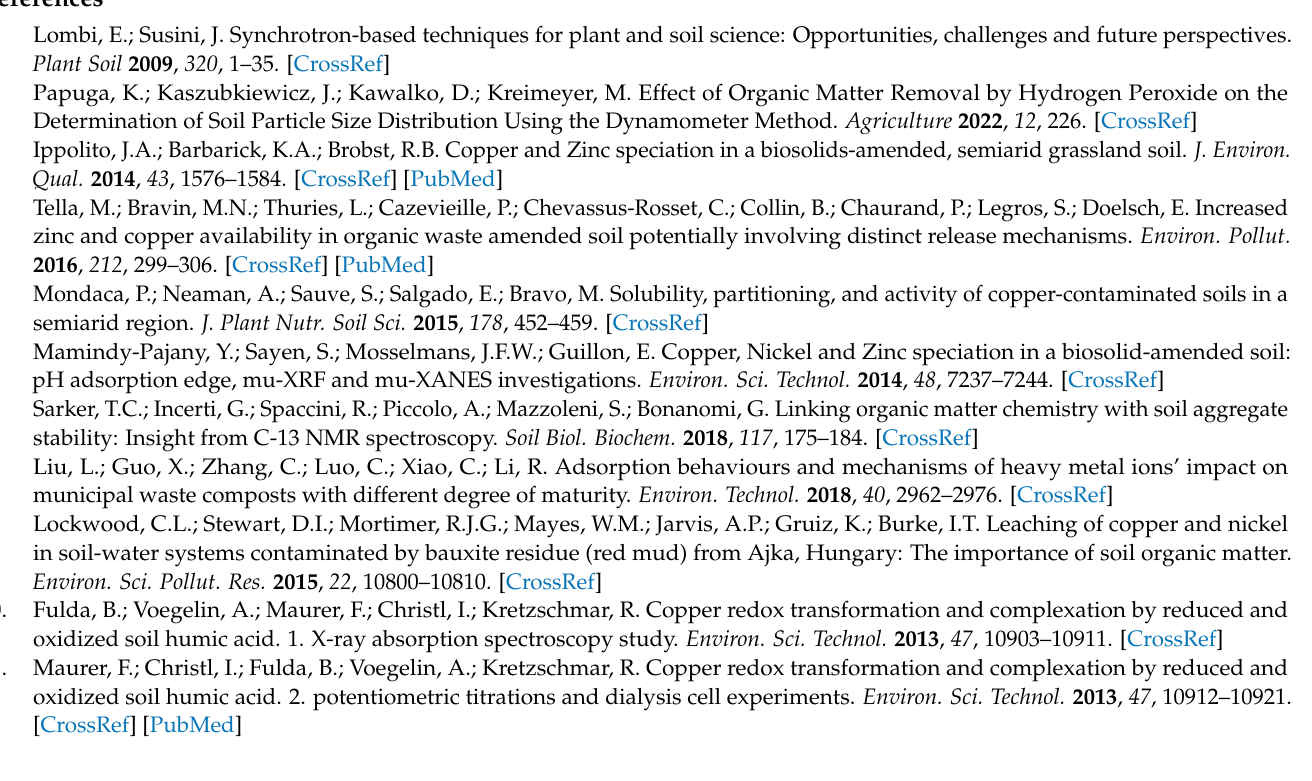
Table S1 The variety and relative amount of saline-alkali soils (Sal.S.) and organic-free saline-alkali soil (Sal.S.-O.C.). Table S2 Fitting parameters for adsorption isotherms of Cu on saline-alkali soil, organic- free saline-alkali soil and biogas residue. Table S3 Thermodynamic parameters for Cu adsorption in oxalic acid and glycine at pH 5 and 25 ◦ C in 1 mol/L KNO3 electrolyte. Table S4 The area of C 1s and Cu 2p from the surface of saline-alkali soils and adsorption Cu, remove organic matter and adsorption Cu after remove organic matter. Table S5 The area of C 1s and Cu 2p from the surface of biogas residue and adsorption Cu. Table S6 The percentage of SEM-EDS of saline-alkali soils after adsorption Cu. Table S7 Relative intensity of major absorption packs in saline-alkali soils (Con.) and application of 2% biogas residue for one season (2% × 1), two seasons (2% × 2), three seasons (2% × 3), four seasons (2% × 4), five seasons (2% × 5). Table S8 The area of Cu 3p from the surface of saline-alkali soils (Con.) and application of 2% biogas residue for one season (2% × 1), two seasons (2% × 2), three seasons (2% × 3), four seasons (2% × 4), five seasons (2% × 5). Table S9 Total organic carbon content in saline-alkali soil, organic-free SAS and biogas